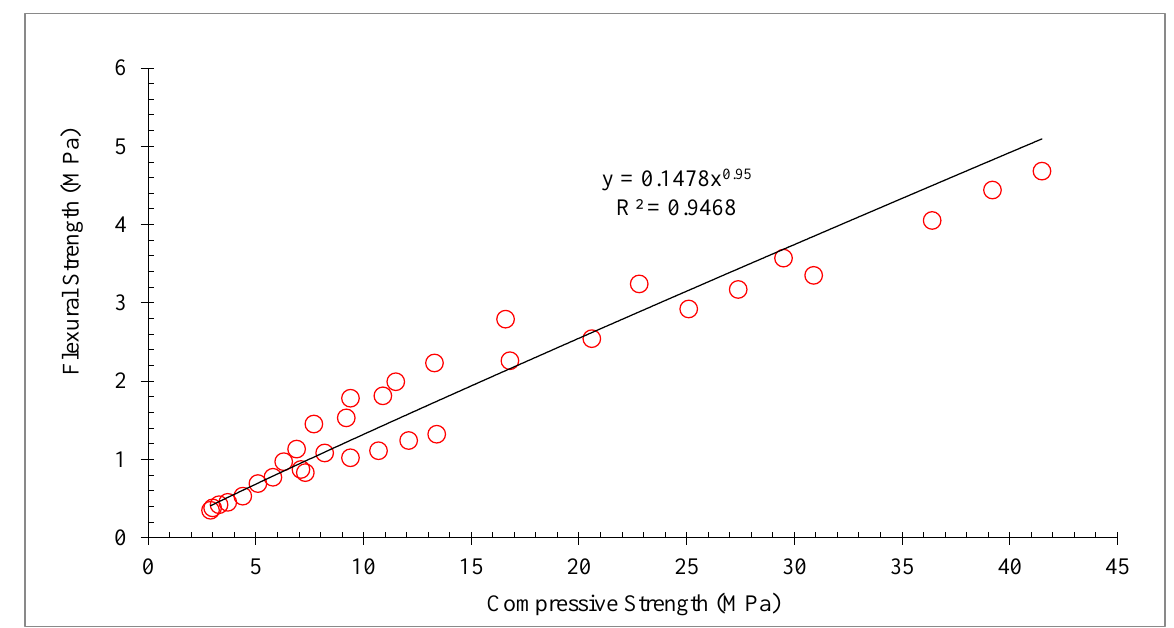
Figure 13. Correlation between compressive and flexure strength: data source [30].